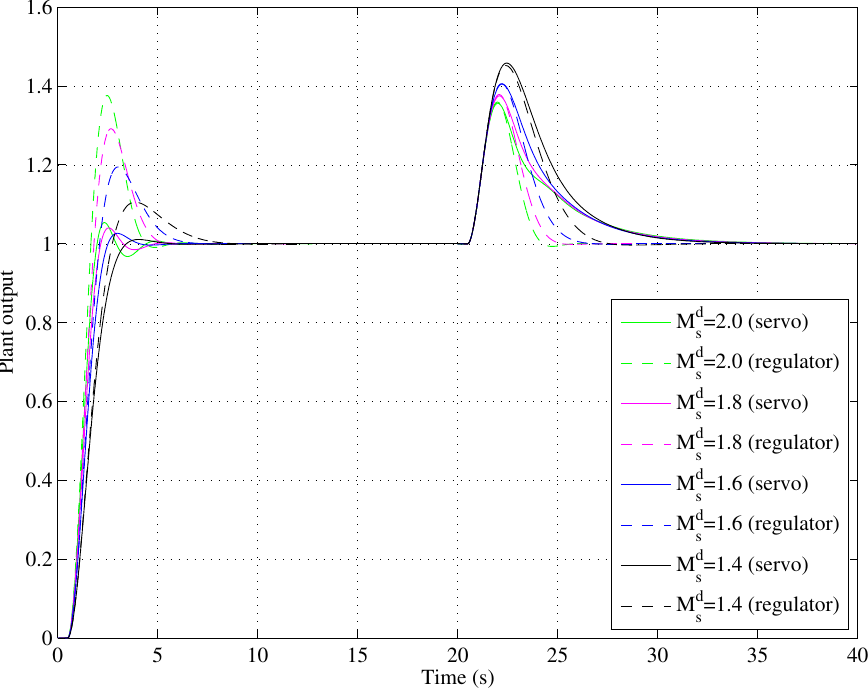
Figure 12. Servo and regulation performances for a = 0.8.